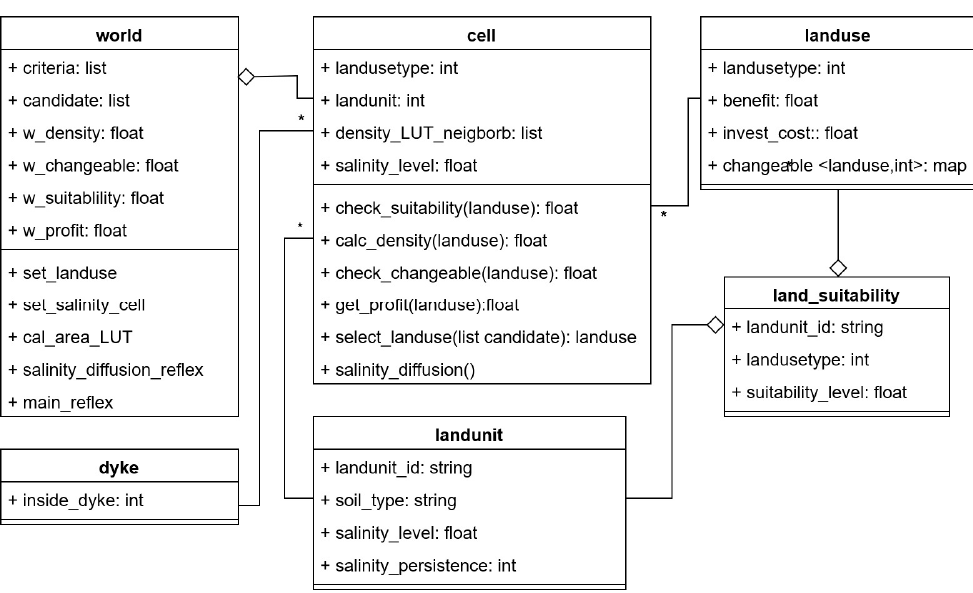
Figure 2. Object diagram of MEKOLUC. * means many in one-to-many relationship, one object in an entity can be associated with one or more objects in another entity. entity can be associated with one or more objects in another